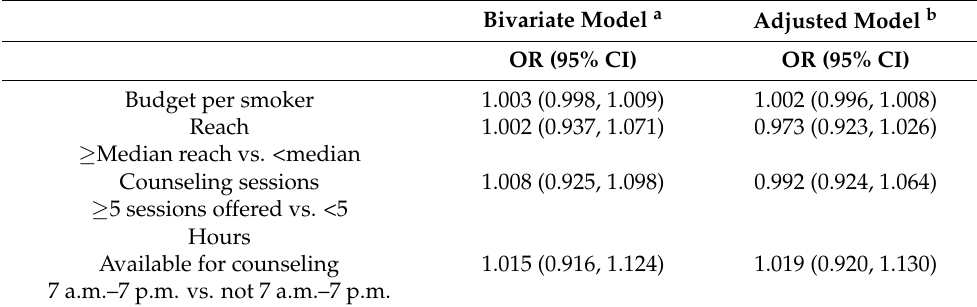
Table A3. Odds ratios for 30-day smoking cessation associated with quitline exposure